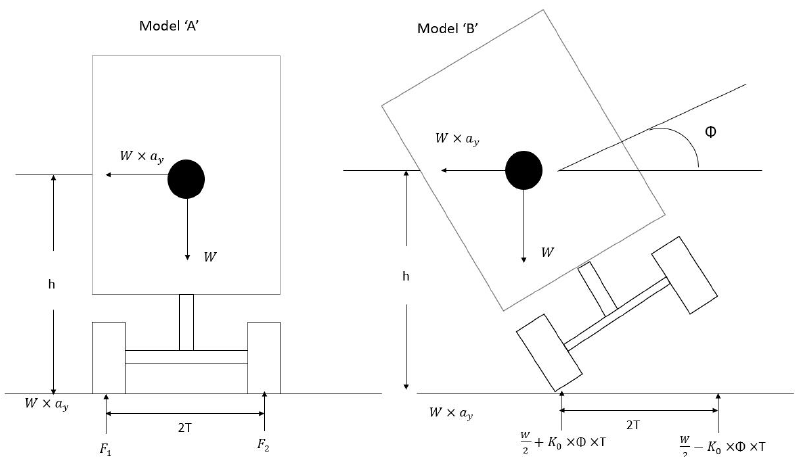
Figure 1. Two rollover models: Model “A”, 0DoF, single-unit rigid vehicle model; Model “B”, 1DoF, compliance vehicle model.